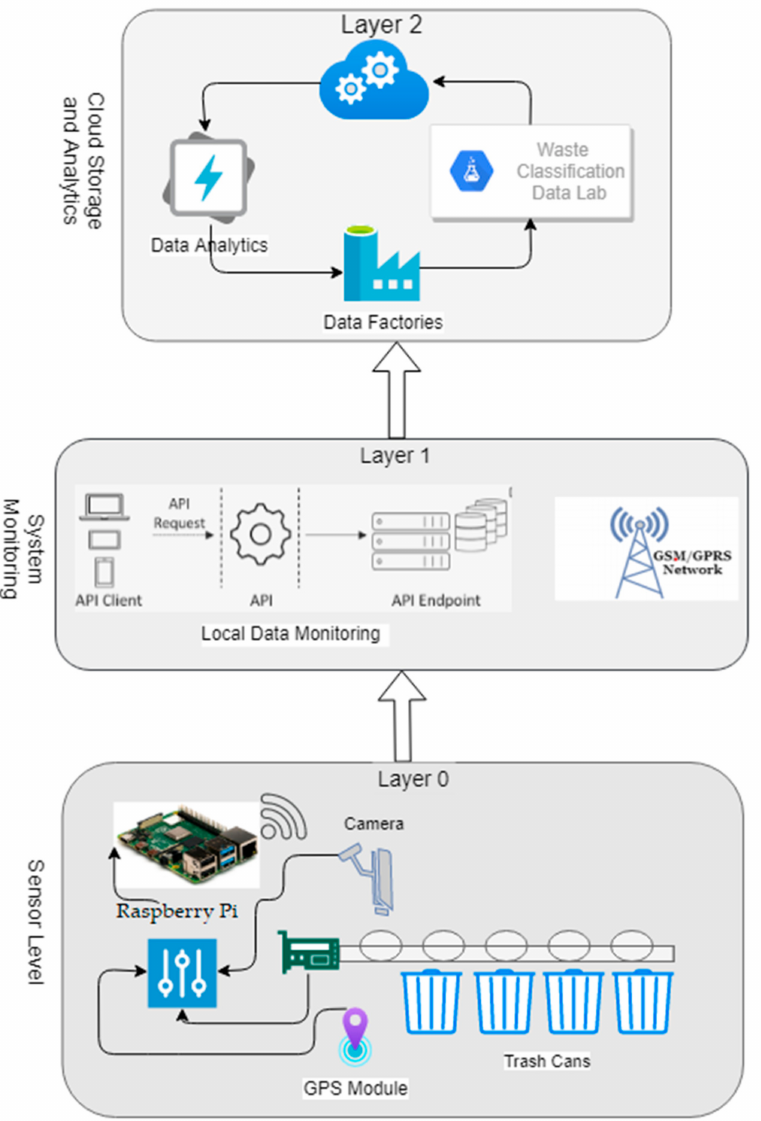
Figure 6. Experimental and system setup